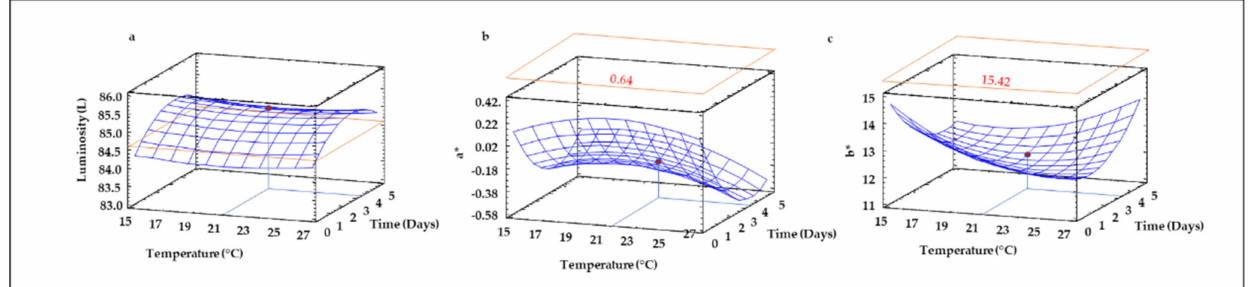
Figure 11. Three-dimensional response surface plots for CIE L*a*b* (CIELAB) parameter: Luminosity ( a ), a* ( b ) and b* ( c ) as a function of the interaction between germination temperature and time. The red line corresponds with the control (ungerminated seed) and the red point with the value for optimum conditions (21 ◦ C and 3.5 days).